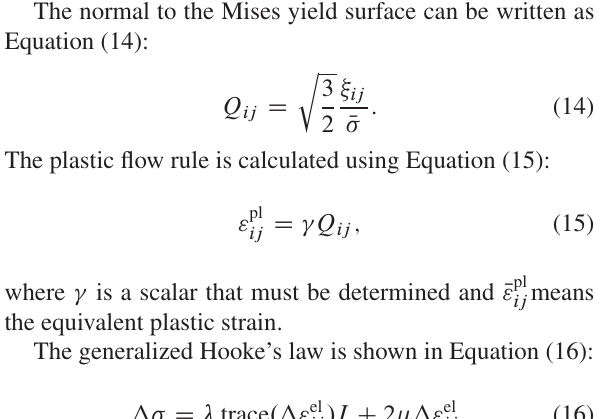
Table 6. New parameters obtained by fitting curves with more